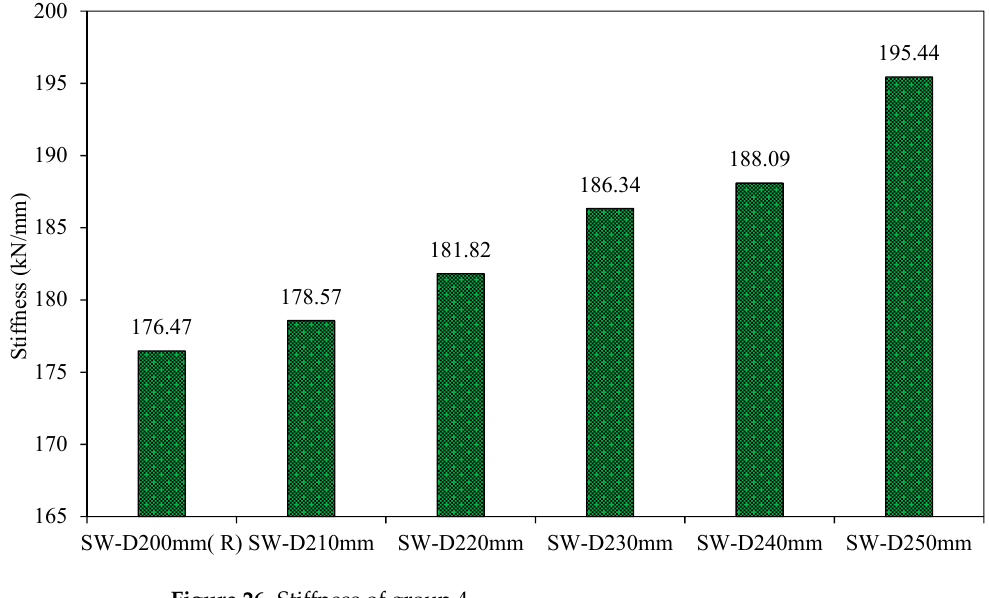
Figure 26. Stiffness of group 4.